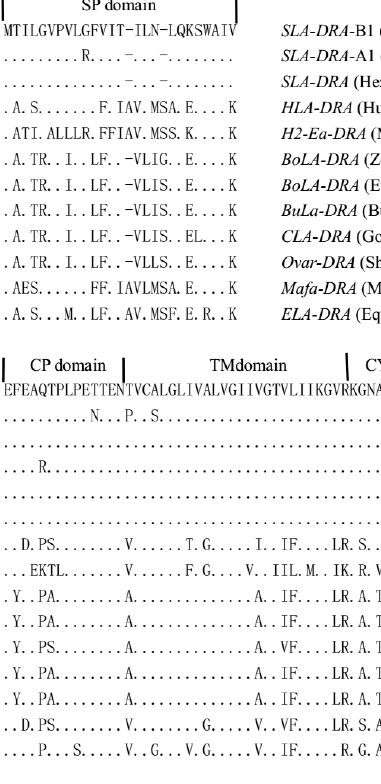
Figure 2. The alignment of the protein encoded by the DRA gene exon 1 and 4 among Yantai black pig and other vertebrates. The DRA genes were downloaded from pig ( S. tibetan , FJ905836), humans ( H. sapiens , NM019111), mice ( M. musculus , NM010381), zebu cattle ( B. indicus , FM986338), European cattle ( B. taurus , D37956), buffaloes ( B. bubalis , DQ016629), goat ( C. hircus , AB008754), sheep ( O. aries , M73983), macaque ( M. mulatta , EF208826) and equus caballus ( E. caballus , NM001284542). Exon 1 and 4 encoded the signal peptide, connecting peptide, transmembrance and cytoplasmic domains. A dot (.) indicates amino acid identity, and the hyphen (-) indicates a gap inserted to maximum